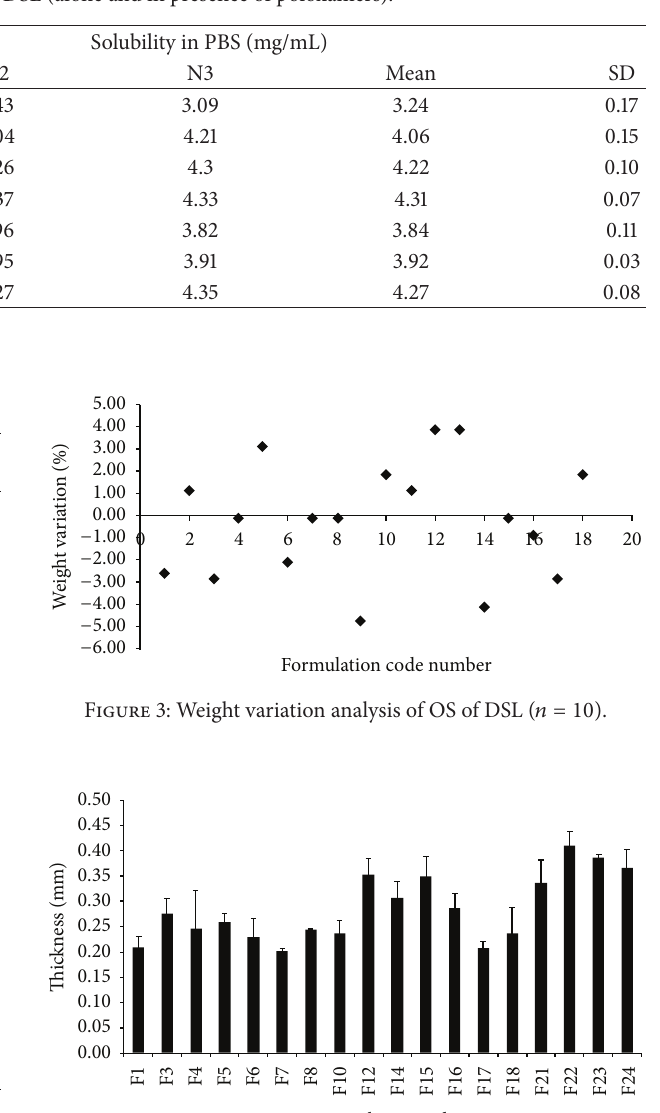
Table 2: Saturated solubility studies of DSL (alone and in presence of poloxamers).